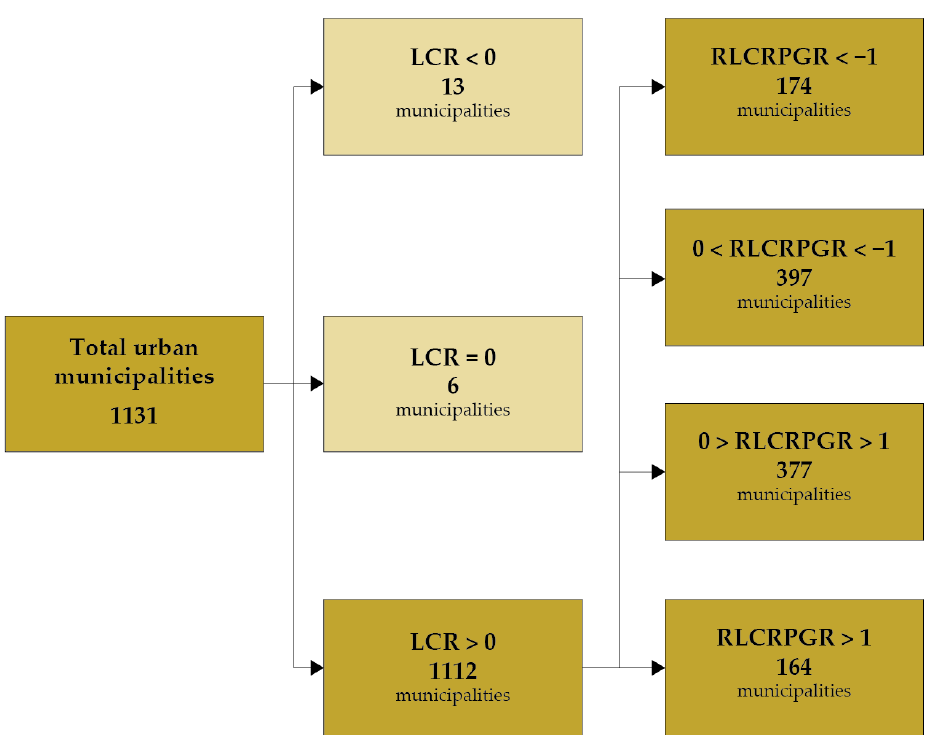
Figure 10. Value of the RLCRPGR indicator in the urban municipalities. In almost all urban municipalities, there is an increase in land consumption. Among these municipalities, just over half also show an increase in population, while in the remaining municipalities, the variations in land consumption and population are uncorrelated. Land consumption between 2012 and 2018 prevails in rural areas; in fact, over one third of the changes fall into the “Rural Cluster”, “Rural Low Density”, and “Rural Very Low Density” classes. Urban classes and periurban/suburban areas each host about a quarter of the total changes, while about 17% of land consumption is in non-residential areas for productive and commercial use. The trend toward land consumption outside the denser urban classes is also recognizable from the analysis of the three